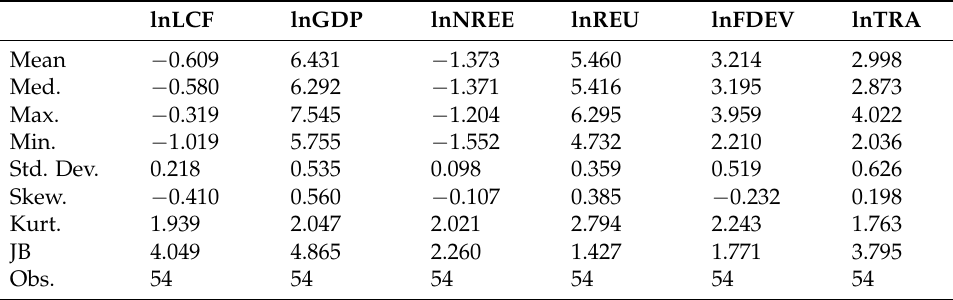
Table 2. Descriptive statistics of variables